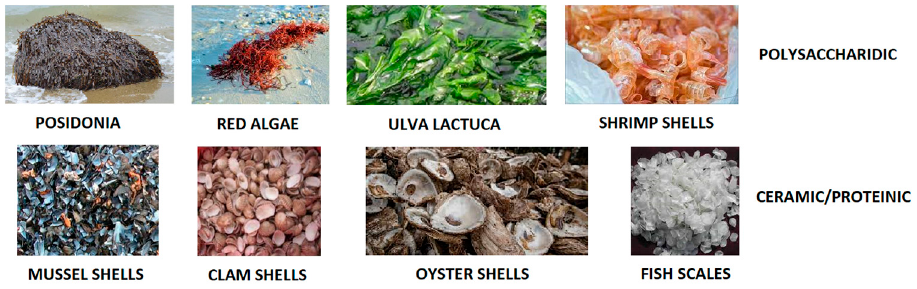
Figure 1. Some of the sea-derived biological waste proposed for use in materials’ development.